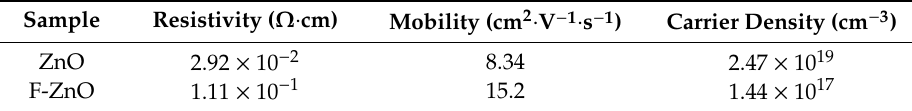
Table 1. The electrical properties of SF 6 plasma passivated ZnO films.